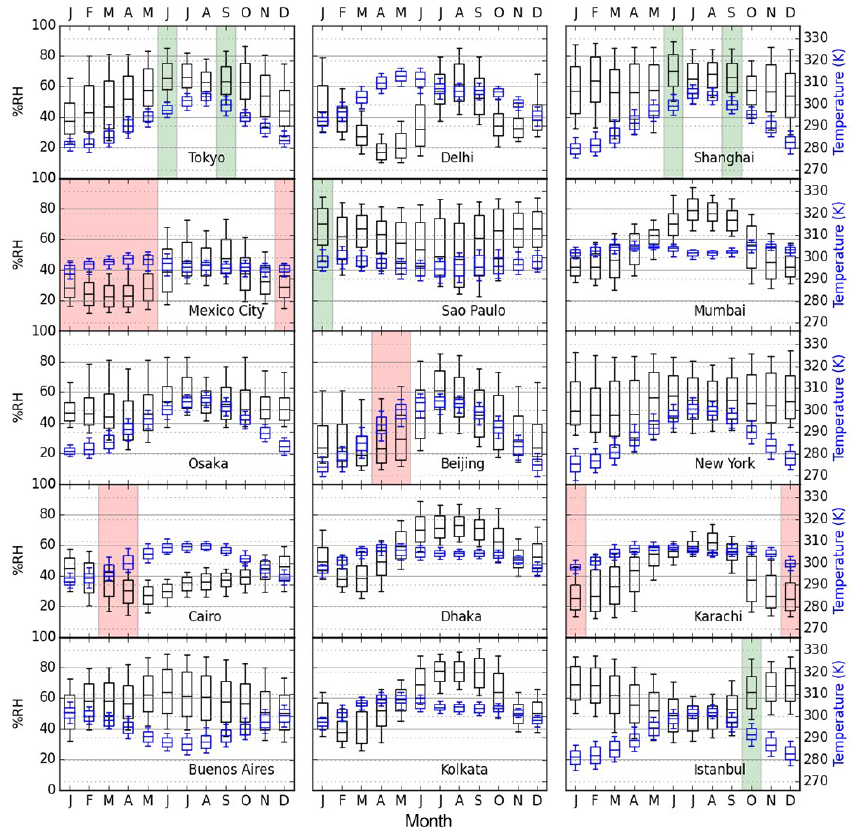
Figure 6. Monthly average RH and temperature for the megacities of Tokyo, Delhi, Shanghai, Mexico City, São Paulo, Mumbai, Osaka, Beijing, New York, Cairo, Dhaka, Karachi, Buenos Aires, Kolkata, and Istanbul. For the stations, afternoon averages RH values (15:00– 17:00LT) were retrieved from NOAA’s National Climate Data Center for the years from 2004 to 2014. Boxes show the median, 25th, and 75th percentiles of 3h averages and the whiskers show the 10th and 90th percentiles. Green shading indicates that the afternoon RH (at the 10th percentile level) does not go below 45%RH and the median afternoon temperature is 290–300K. Red shading indicates that the afternoon RH (at the 10th percentile level) is 17% or lower and the median afternoon temperature is